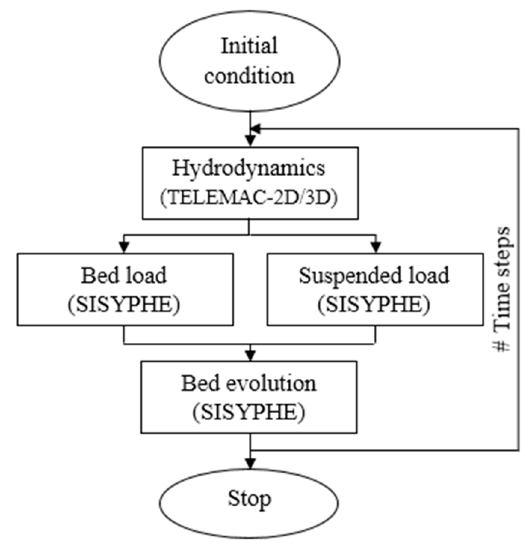
Figure 1. Scheme of a hydro-morphodynamic model system.